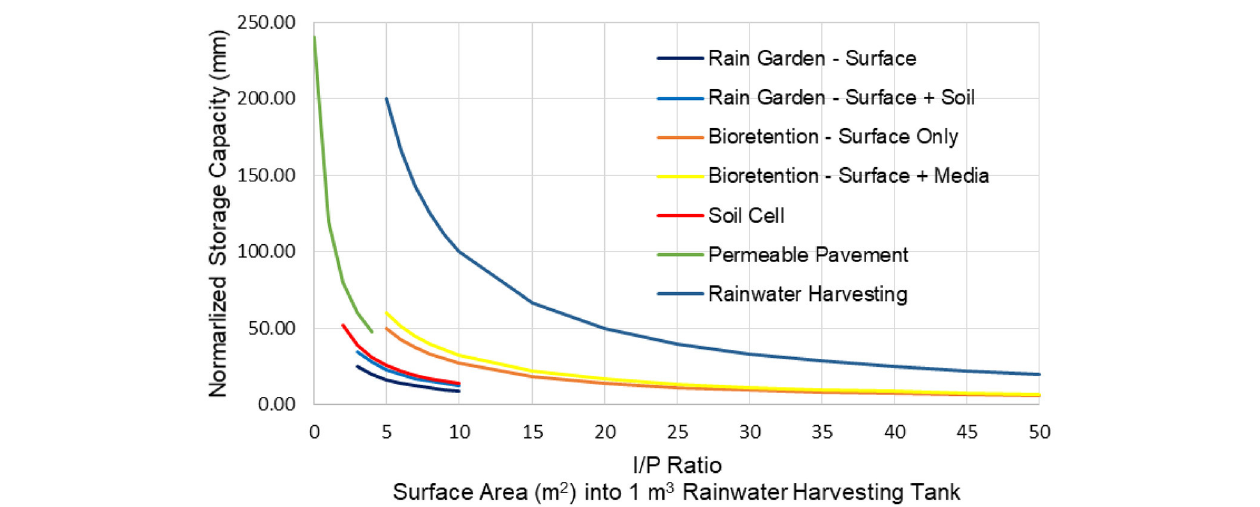
FIGURE 6 | Normalized Storage Capacity available within Source Control Measures; Assumptions: Rain Garden 100mm ponding; 300mm thick soil; porosity—field capacity = 0.13; Bioretention 300mm ponding; 450mm thick media; porosity—field capacity = 0.13; Soil Cell no ponding; 1,200mm thick media; porosity—field